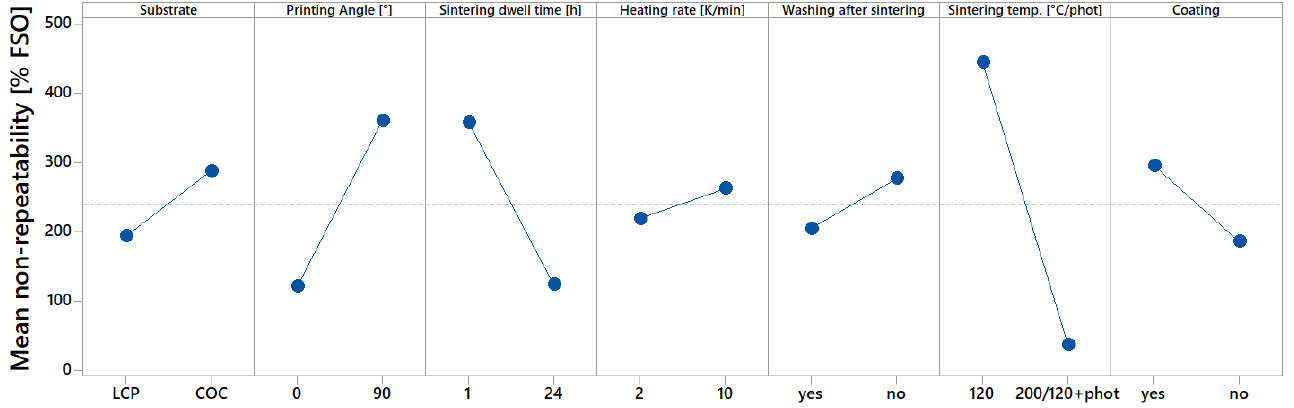
Figure 11. Main effect diagram, which indicates influences of manufacturing parameters on non- repeatability [% FSO].